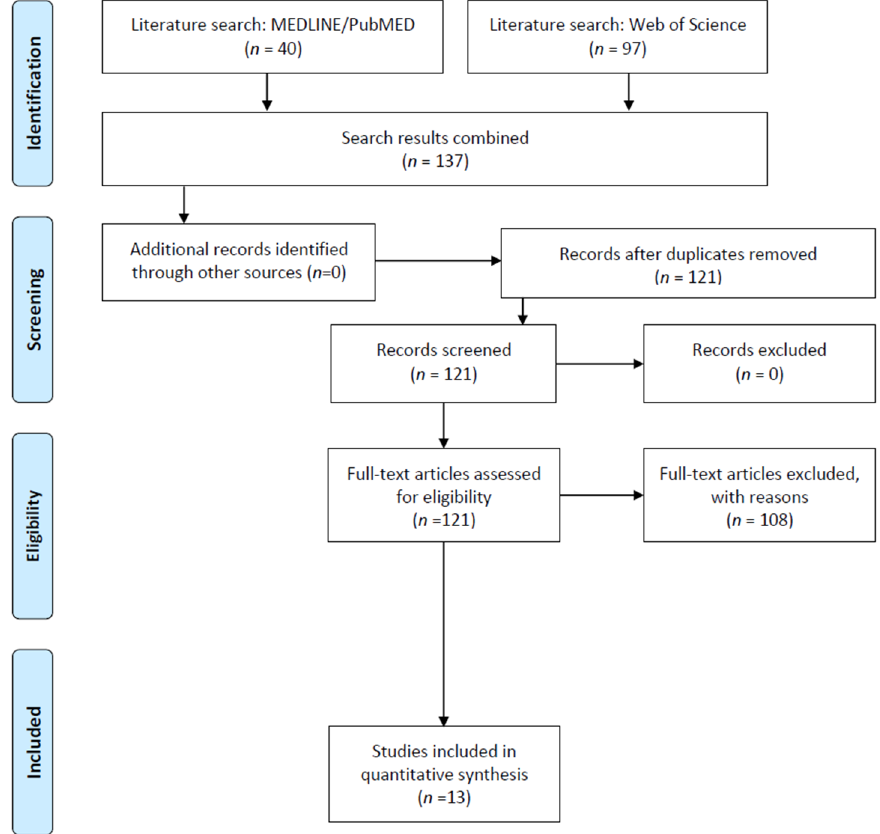
Figure 3. Flow diagram of study’s selection based on PRISMA guidelines [50].